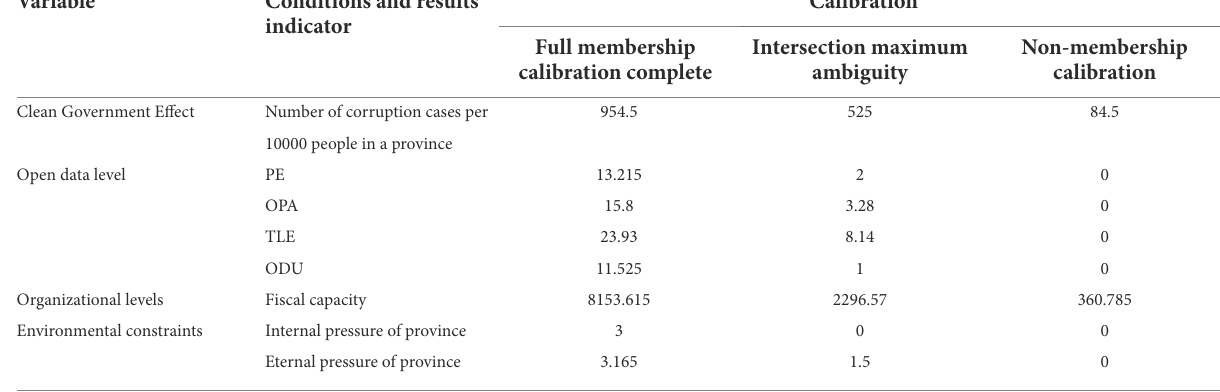
TABLE 4 Data calibration and standardization (2019-2020).